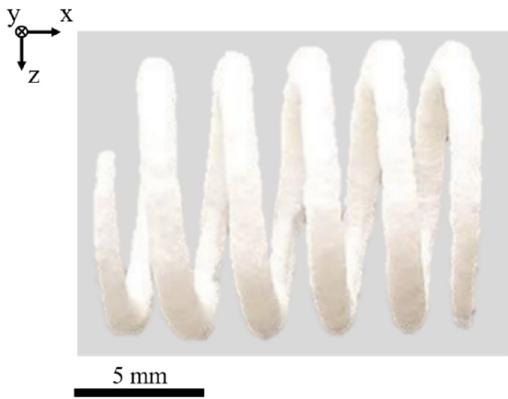
Figure 14. Depiction of a compression spring, manufactured by means of support-free low tempera- ture PBF, T B = 75 °C.